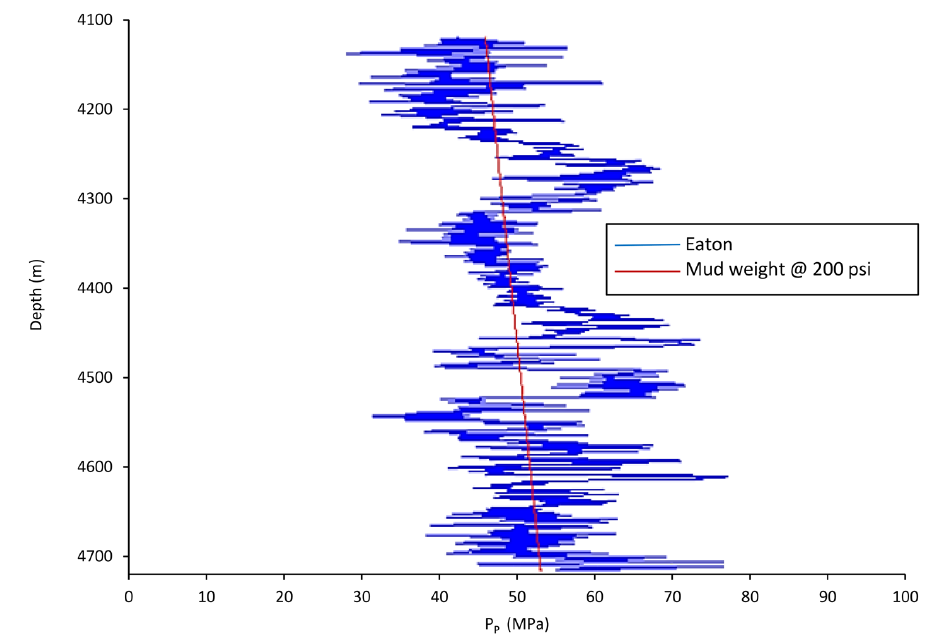
Figure 14. Changes in pore pressure vs. the depth of wellbore-D in the Azar oilfield. Figure 15 represents the results of in-situ stresses (i.e., the vertical, minimum, and maximum horizontal stress) and pore pressure obtained from wellbore-D of the Azar oilfield.